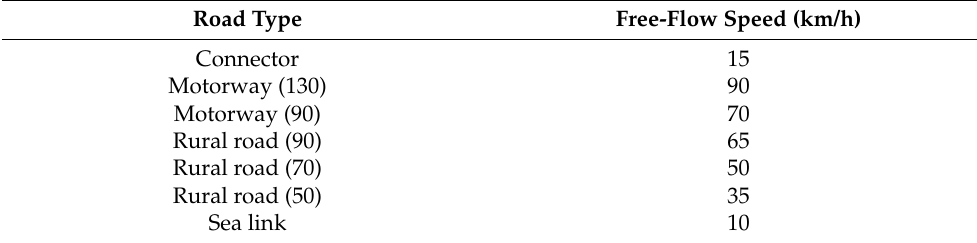
Figure 6. Study area and zoning (national model). Table 3. Free-flow speeds for HGVs (national model) [4].